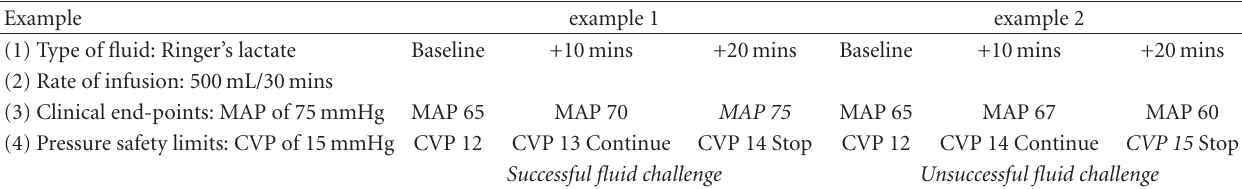
Table 3: Critical components of the fluid challenge and one example of their application in a hypothetical patient (MAP of 65 mmHg and a CVP of 12mmHg; two possible types of response are presented)